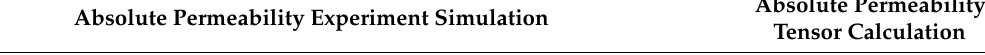
Table 4. The configurations of the micro-hydromechanics simulation.